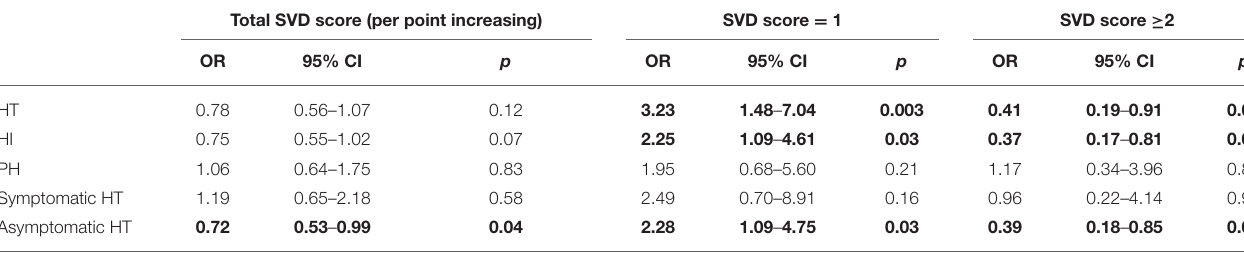
TABLE 2 | Multivariate binary logistic regression to evaluate potential associations between the total SVD score and HT. Total SVD score (per point increasing)